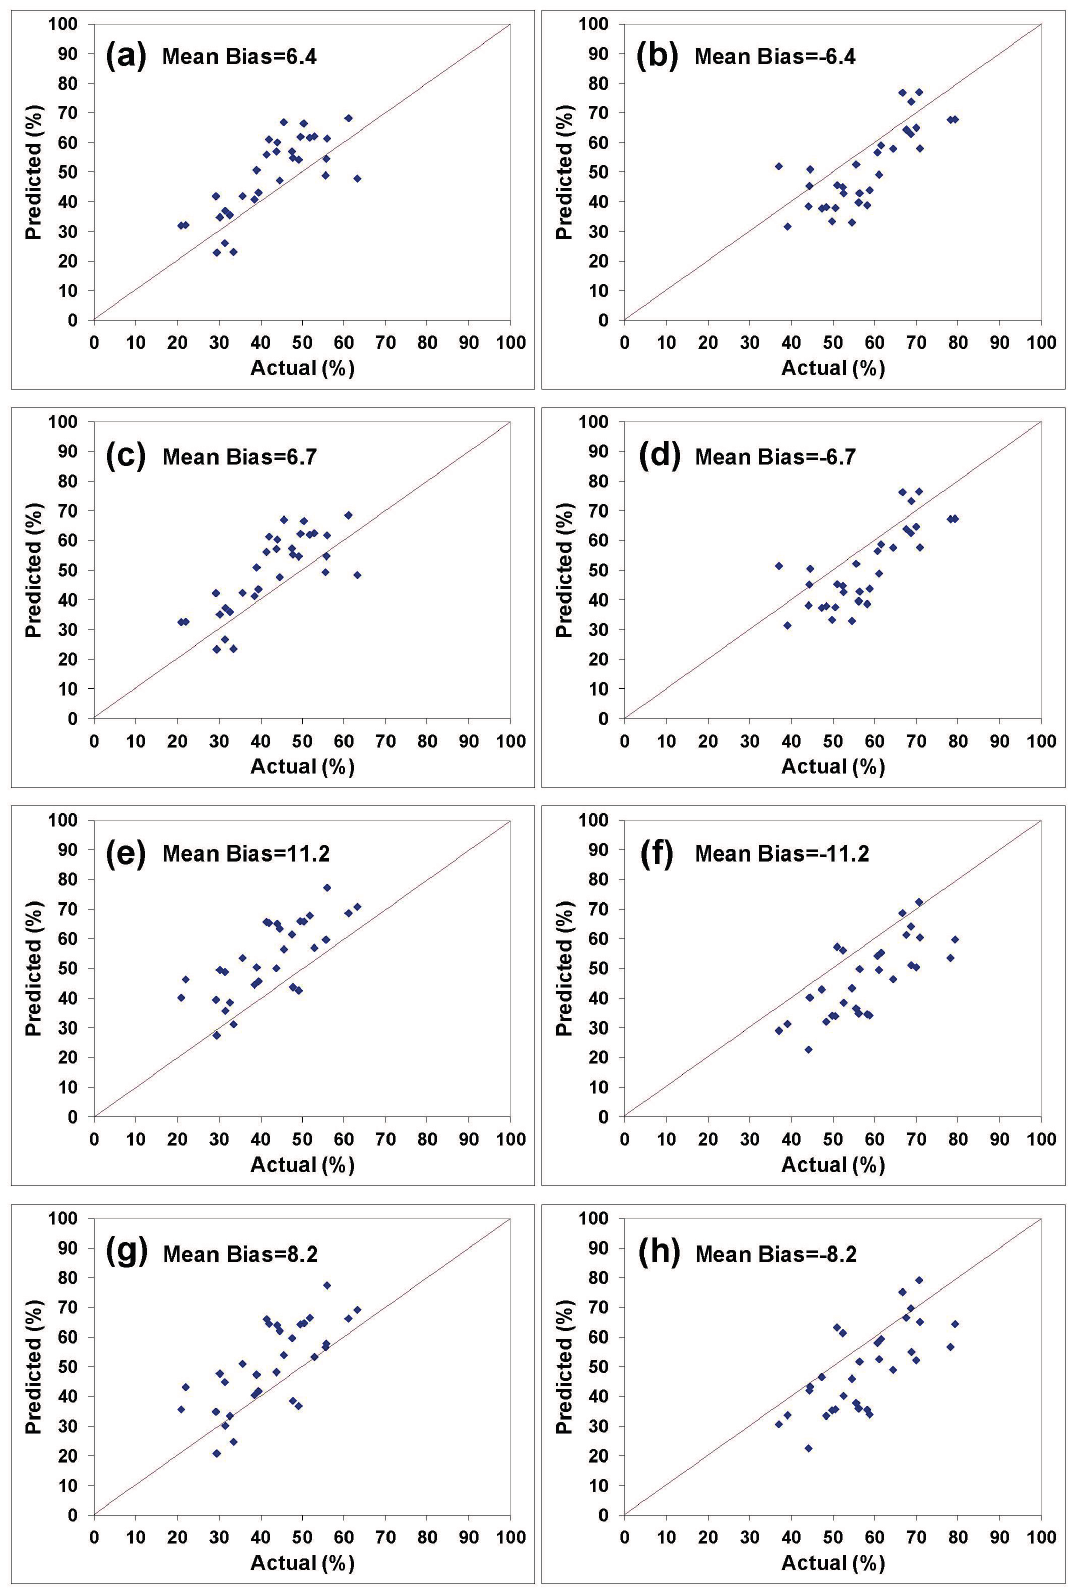
Figure 9. Actual vs. Predicted Plots for Categories of Species Prediction Models: ( a ) Hardwood (FD), ( b ) Softwood (FD), ( c ) Hardwood (FD, Elevation), ( d ) Softwood (FD, Elevation), ( e ) Hardwood (I), ( f ) Softwood (I), ( g ) Hardwood (I, Elevation), ( h ) Softwood (I,